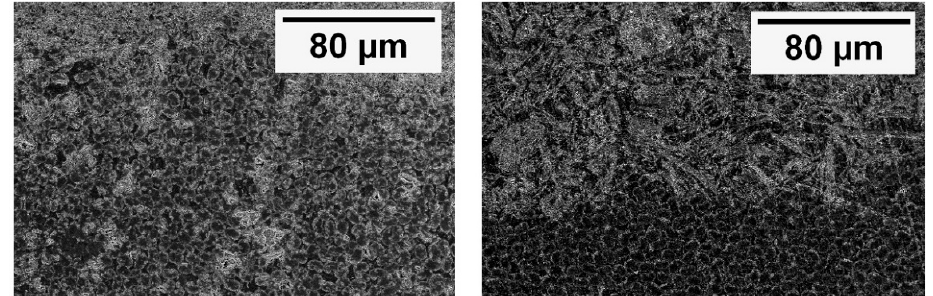
Figure 10. SEM records of the prepreg laminates, left: with small particles of 3.6 μ m; and right: with particles of 18.4 μ m.